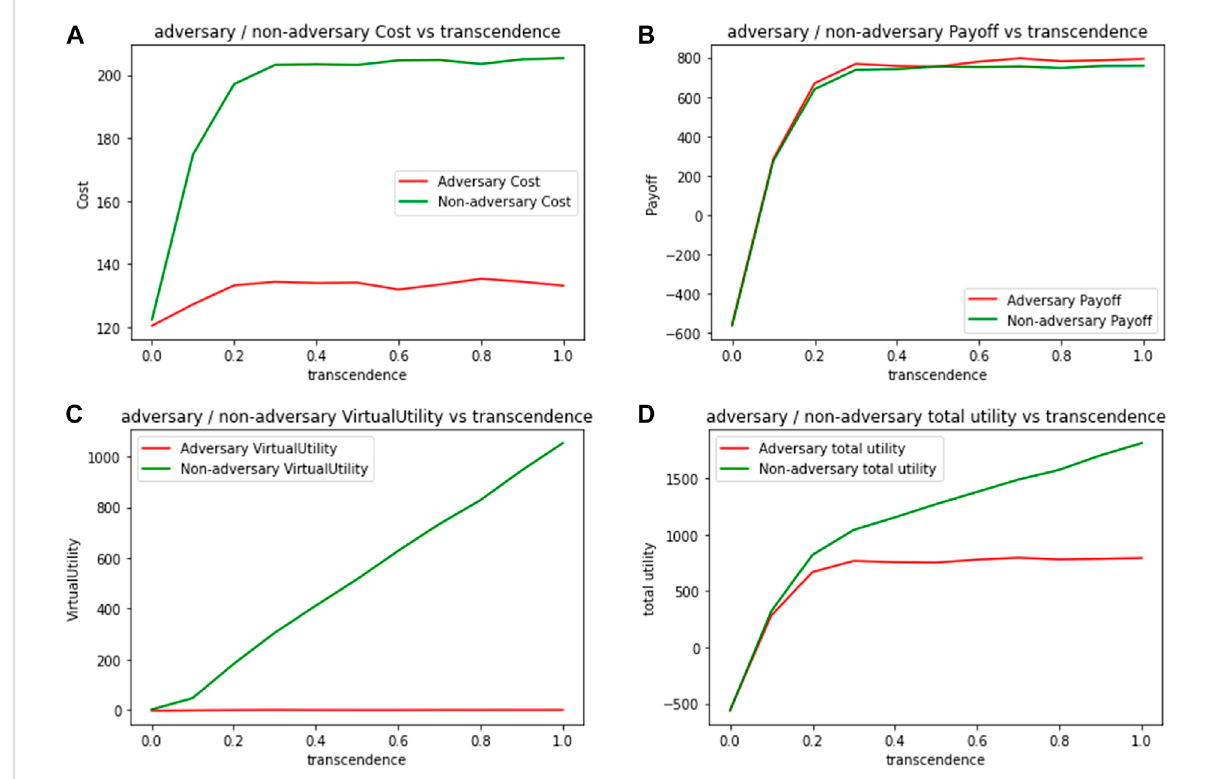
FIGURE 8 Expected metrics per 100 packets for adversarial and non-adversarial agents by varying transcendence (A) Cost (B) Payoff (C) Virtual Utility (D) Total